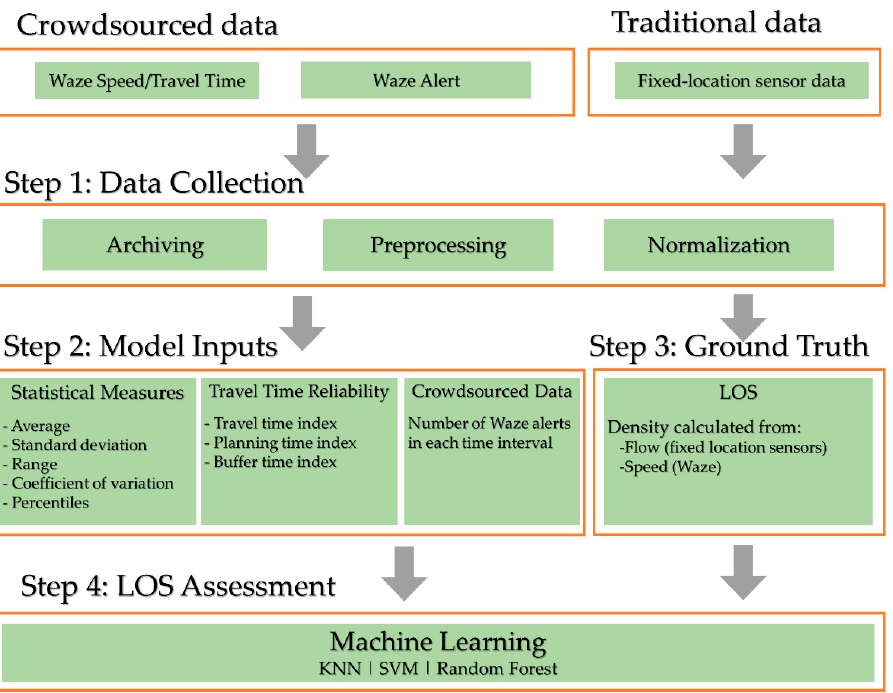
Figure 2. Framework of the proposed methodology.